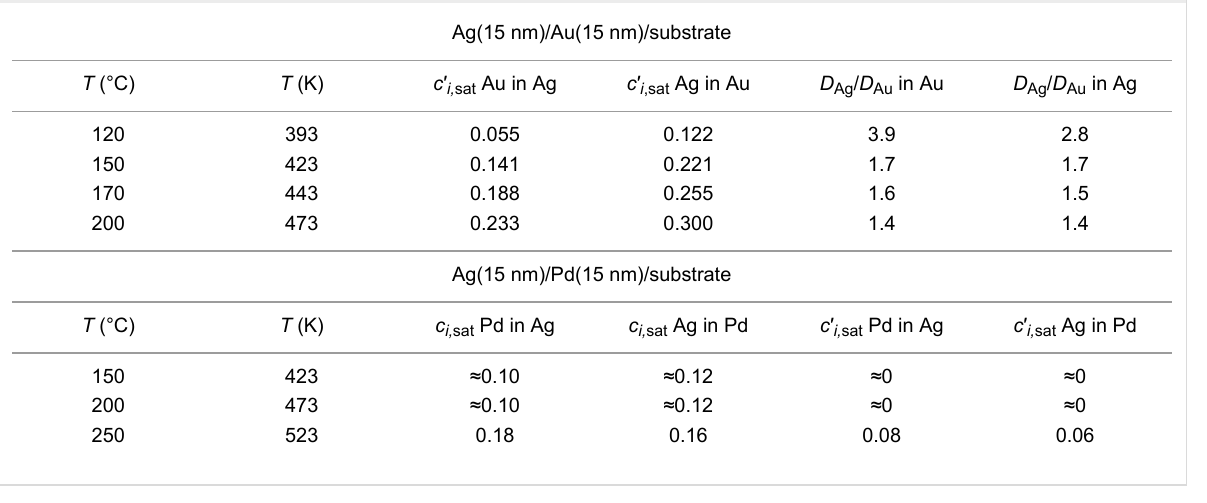
Table 1: Saturation values ( c i ,sat ) as read out from the SNMS profiles and corrected ( c ′ i ,sat ) according to Equation 3 in the Ag(15 nm)/Au(15 nm)/sub- strate system and in the Ag(15 nm)/Pd(15 nm)/substrate system at different temperatures. The estimated D Au / D Ag ratios of the GB diffusion coeffi- cients are also shown in (a).